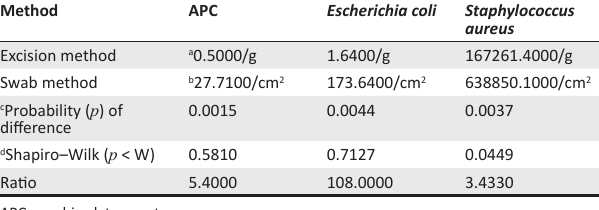
FIGURE 3: Correlation and scatter plot between the two sampling techniques with different measuring units from the spiked aerobic plate TABLE 1: Means of the excision and swab methods.